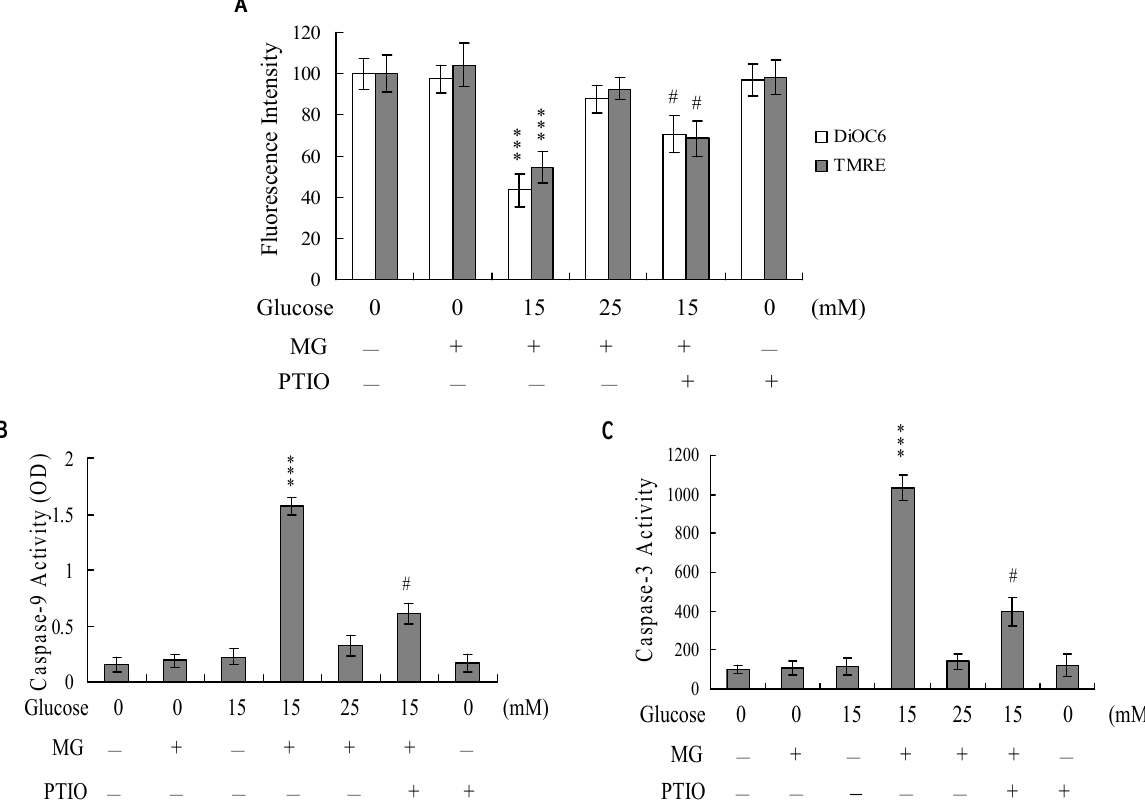
Figure 5. MMP changes and activation of caspase-9 and -3 following MG/HG treatment of